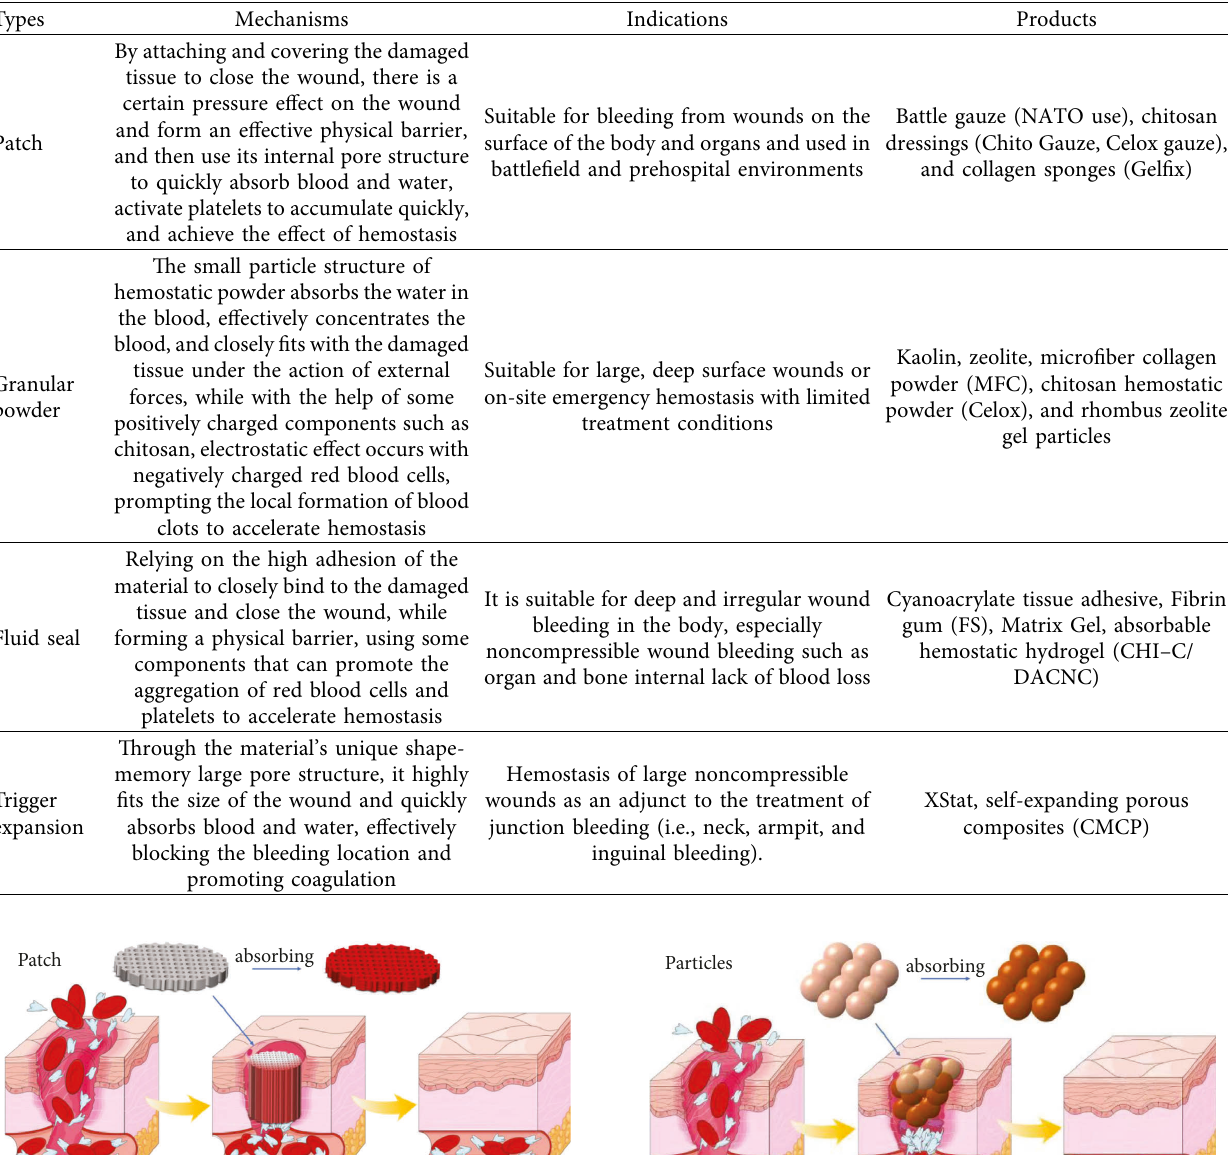
Table 1: Features of various hemostatic materials.